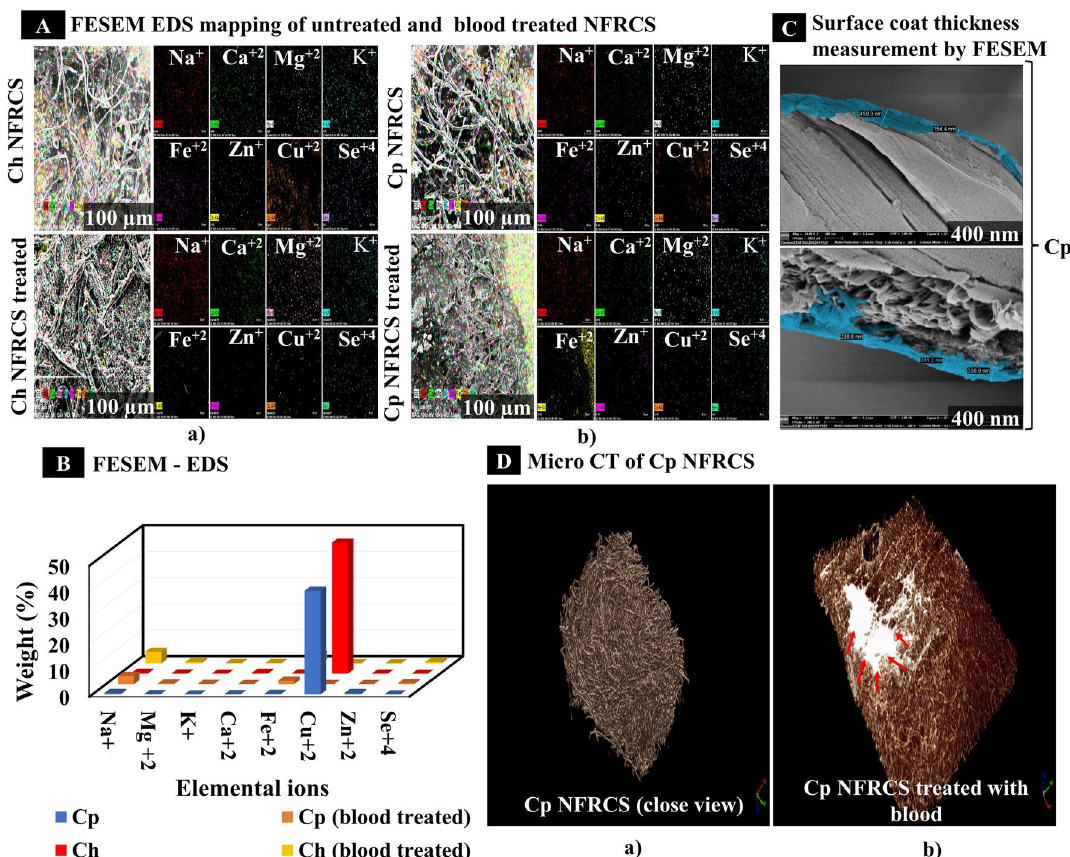
Figure 5. FESEM, EDS mapping, and micro- CT of NFRCS samples. ( A ) a). FESEM-EDS mapping of Ch NFRCS and Ch NFRCS treated with blood; b). FESEM-EDS mapping of Cp NFRCS and Cp NFRCS treated with blood. ( B ) Graphical representation of elemental ions mapped in blood treated and untreated NFRCS of Ch and Cp, ( C ) Thickness of surface coat on the surface of Ct by using FESEM (the HFFC was able to form nano thickness film ranges from 150 to 500 nm). ( D ) a). Represents the 3D simple ware ScanIP Academic software (https:// www. synop sys. com/ simpl eware/ softw are. html) modified micro-CT image of a close view of NFRCS; b). The image represents the modified micro-CT image of Cp NFRCS after blood